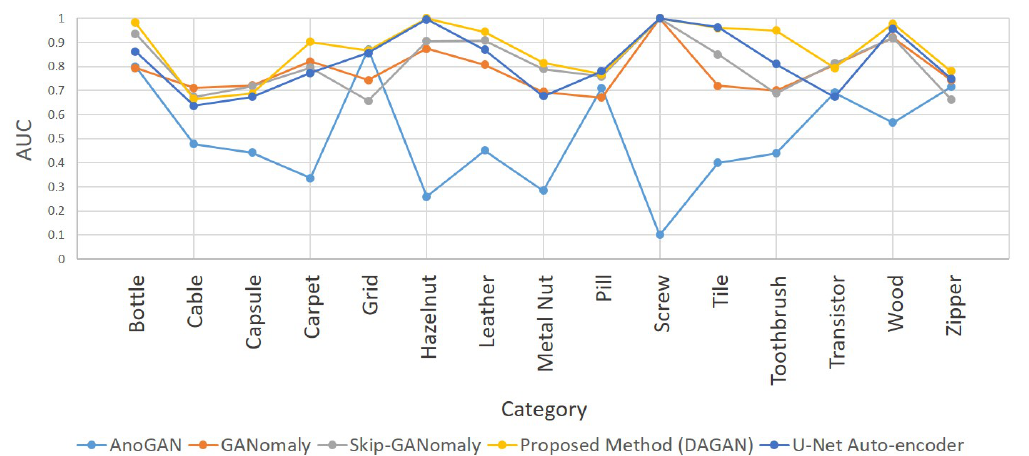
Figure 7. AUC after testing the proposed method (DAGAN) and three other GAN-based anomaly detection models with the MVTec AD dataset.